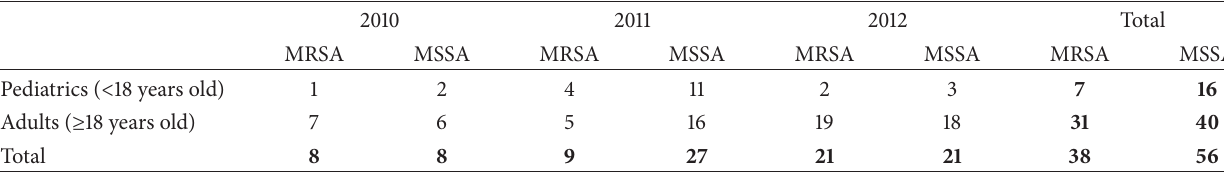
Table 2: Age groups of patients infected with MRSA and